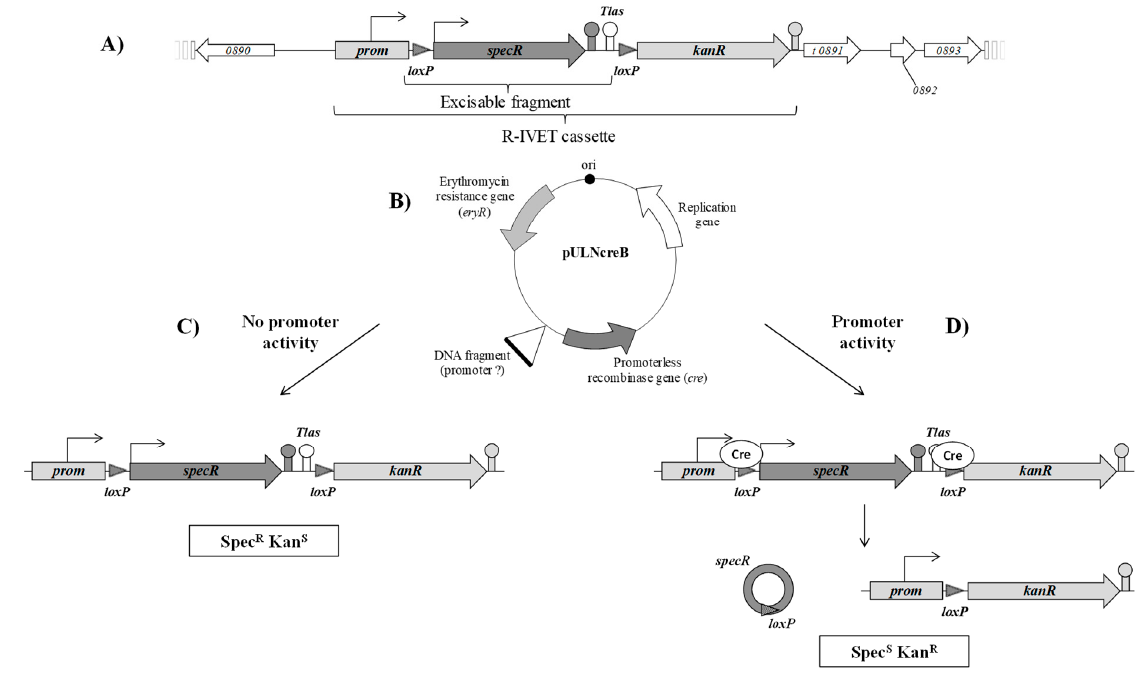
Figure 3. Schematic representation of positive ‐ selection R ‐ IVET screen in S. thermophilus STUL5003 . The R ‐ IVET technology consists of two elements. The first one is the chromosomal cassette ( A ) with the spectinomycin resistance gene ( specR ) flanked by two loxP sites followed by the promoterless kanamycin resistance gene ( kanR ). The second element is the pULNcreB plasmid ( B , Table 1) which possesses the promoterless recombinase gene ( cre ). Cre recombinase recognizes the loxP sites of the cassette. ( C ) When the DNA fragment cloned upstream of the cre gene is without promoter activity, only the specR gene is expressed and the two terminators, i.e., specR gene and Tlas downstream of the specR gene, prevent expression of the kanR gene. The corresponding clone is spectinomycin ‐ resistant and kanamycin ‐ sensitive (Spec R Kan S ). ( D ) When the DNA fragment possesses promoter activity, Cre recombinase is produced and leads to excision of the specR gene; the kanR gene can, therefore, be expressed from its own promoter. Hence, the clone is spectinomycin ‐ sensitive and kanamycin ‐ resistant (Spec S Kan R ).